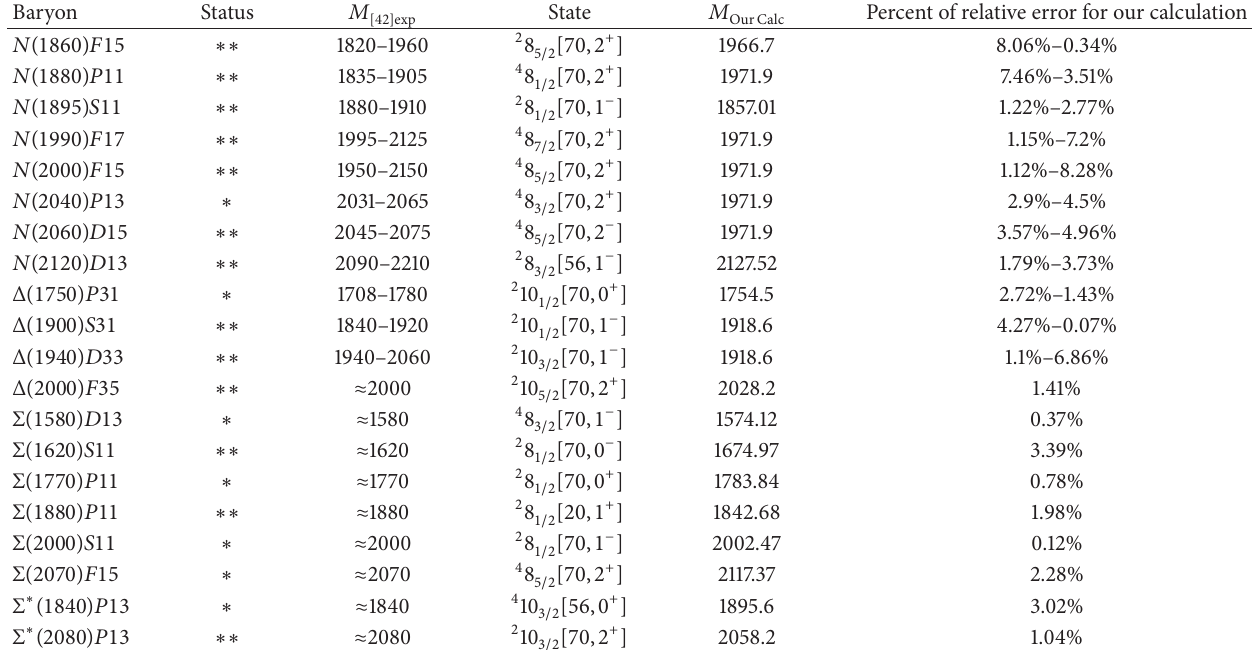
Table 5: Mass spectrum of some of 1 and 2 star baryons resonances (in MeV) up to 2.1 GeV calculated with the mass formula (22). column 𝑀 OurCalc contains our calculations with the parameters of Table 2 and column 6 indicates the percentage of relative error for our